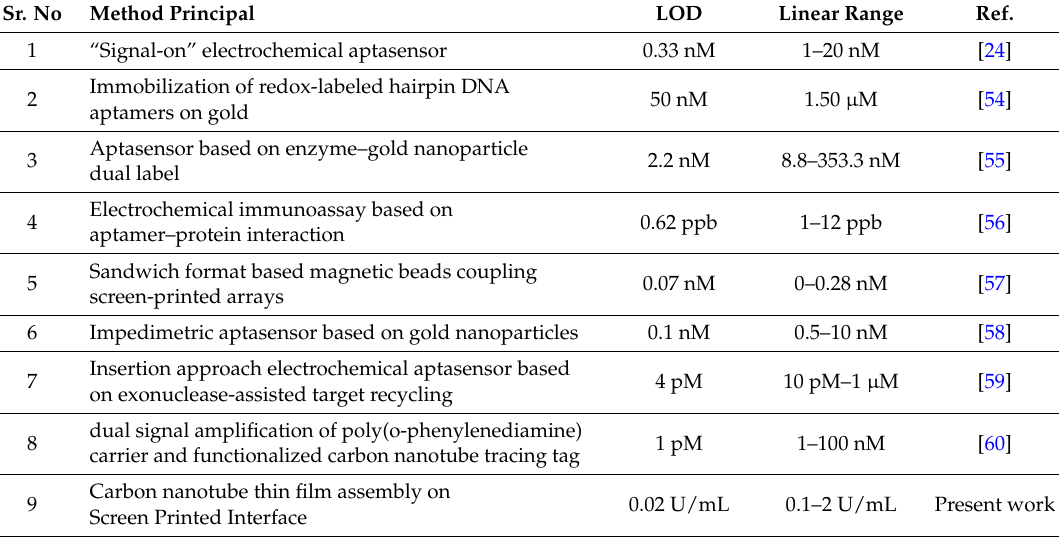
Table 1. Analytical performance of the proposed aptasensor with the previously reported electrochemical sensors for detection of